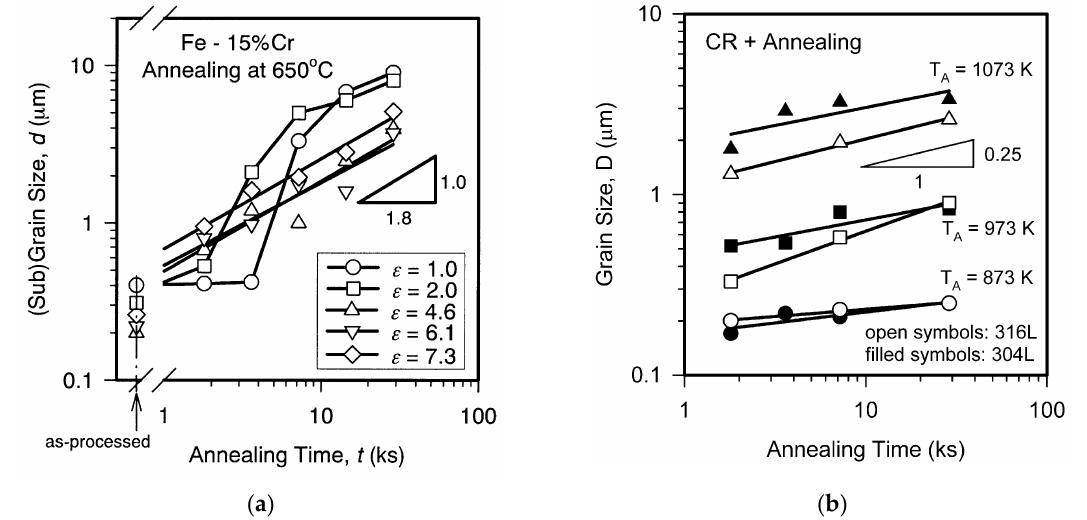
Figure 30. Grain/subgrain coarsening in a cold worked Fe-15%Cr steel during annealing at 923 K ( a ) and in 304L and 316L steels cold rolled to a strain of 3 and annealed at 873–1073 K ( b ). Reproduced from [103, 104] with permission from Springer Nature, 2023.